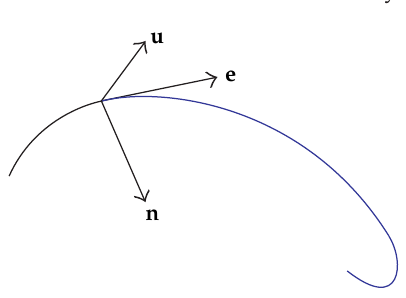
Figure 2.1 . The drift u of a bent vortex filament in relation to its curvature κ n and vorticity e